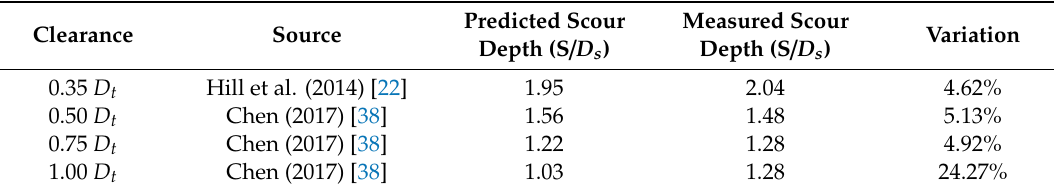
Table 6. Seabed scour depth at various tip clearances.